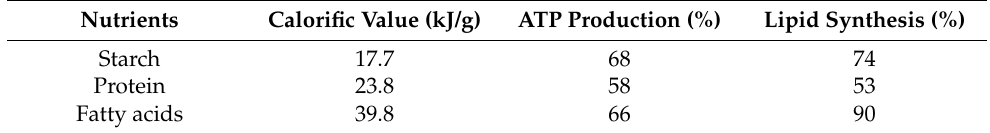
Table 2. The biochemical efficiency of absorbed nutrients for ATP and lipid synthesis; reviewed in [72].